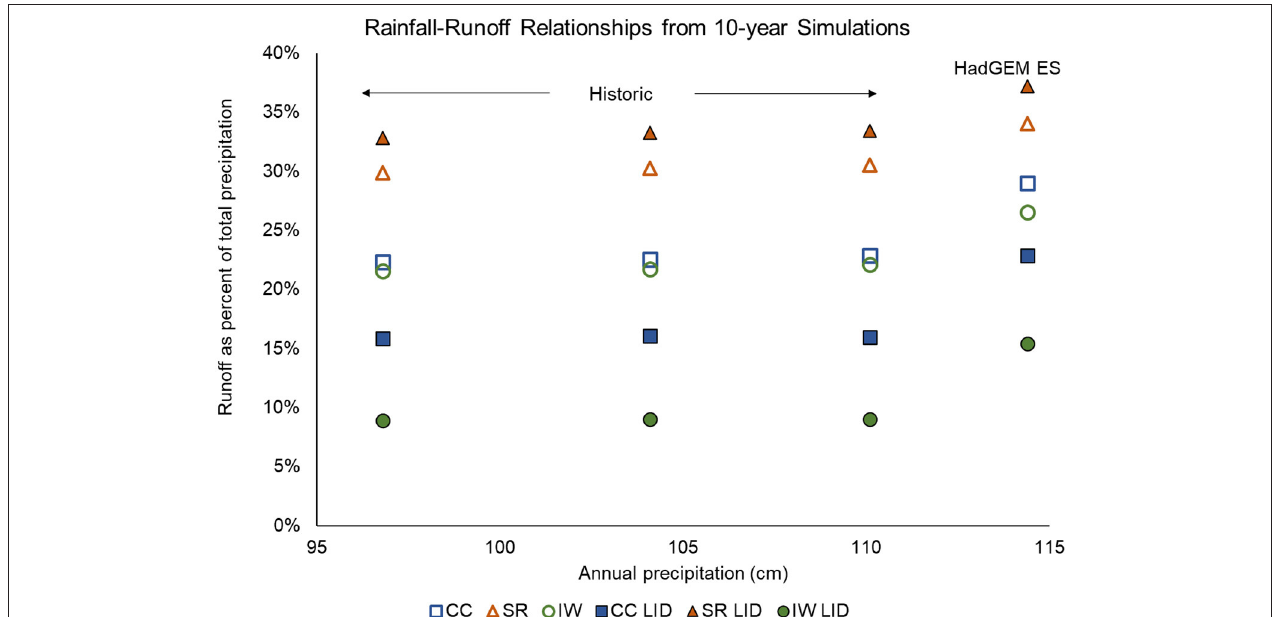
FIGURE 6 | Rainfall-runoff relationships from the 10-year continuous simulations. The values on the X-axis are the average annual precipitation for the decade. Included here are results from simulations of future climate projected by the HadGEM-ES for 2060–2069 (114cm, at the far right) as well as results from simulations of historic data for 1956–1966 (dry decade with average annual precipitation of 98cm), 1966–1977 (wet decade, average annual precipitation 110cm), and 1975–1985 (average decade, average annual precipitation 104cm). All 10-year periods start on October 1. Solid symbols are for the scenarios with LID incorporated, open symbols are for scenarios without LID features. Symbols used are circles for the IW future results, squares for the CC results, and triangles for the SR results.